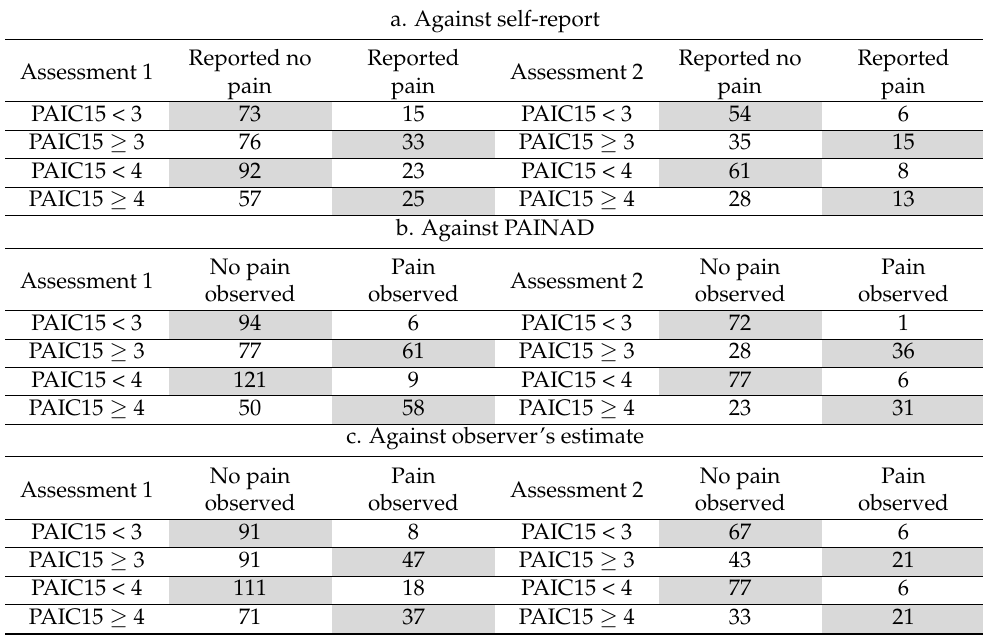
Table 8. Cross-tabulations of two PAIC15 cut-offs at two assessments by the three standards (counts). a. Against